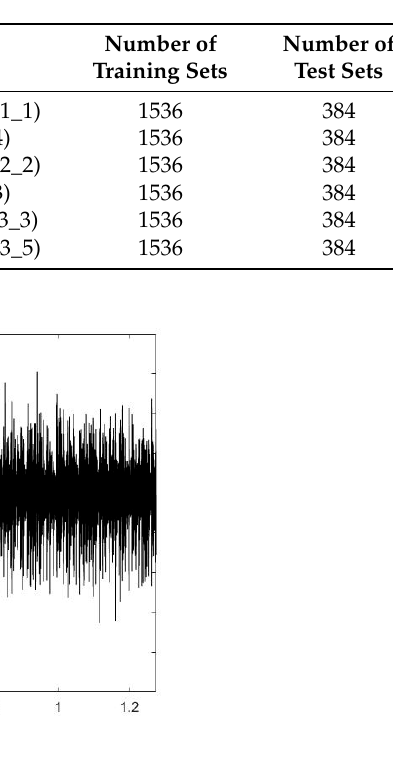
Table 4. XJTU-SY Dataset Description.